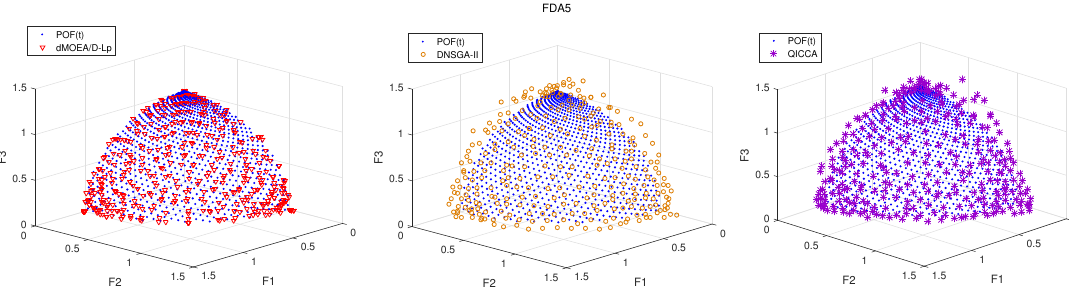
Figure 8. Solution sets obtained by three algorithms at t = 10.2 on FDA5 in case of τ T = 15, n T =